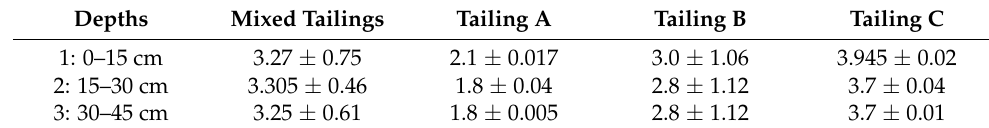
Table 2. pH measurements of the different tailings.